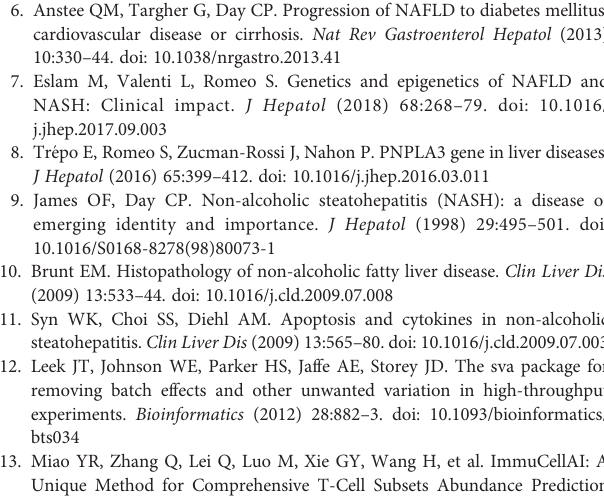
SUPPLEMENTARY FIGURE 1 | Immune landscape in NAFLD patients and HCC patients. (A) Survival analysis of immune cells in HCC patients; (B) Relationship of AKR1B10/SPP1 and survival-related immune cells; (C – E) Relationship between the AKR1B10/SPP1 and immunosuppressive cytokines